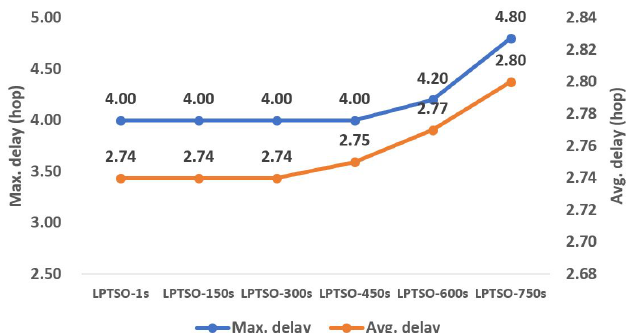
Figure 6. Network average delay and maximum delay with different time segment